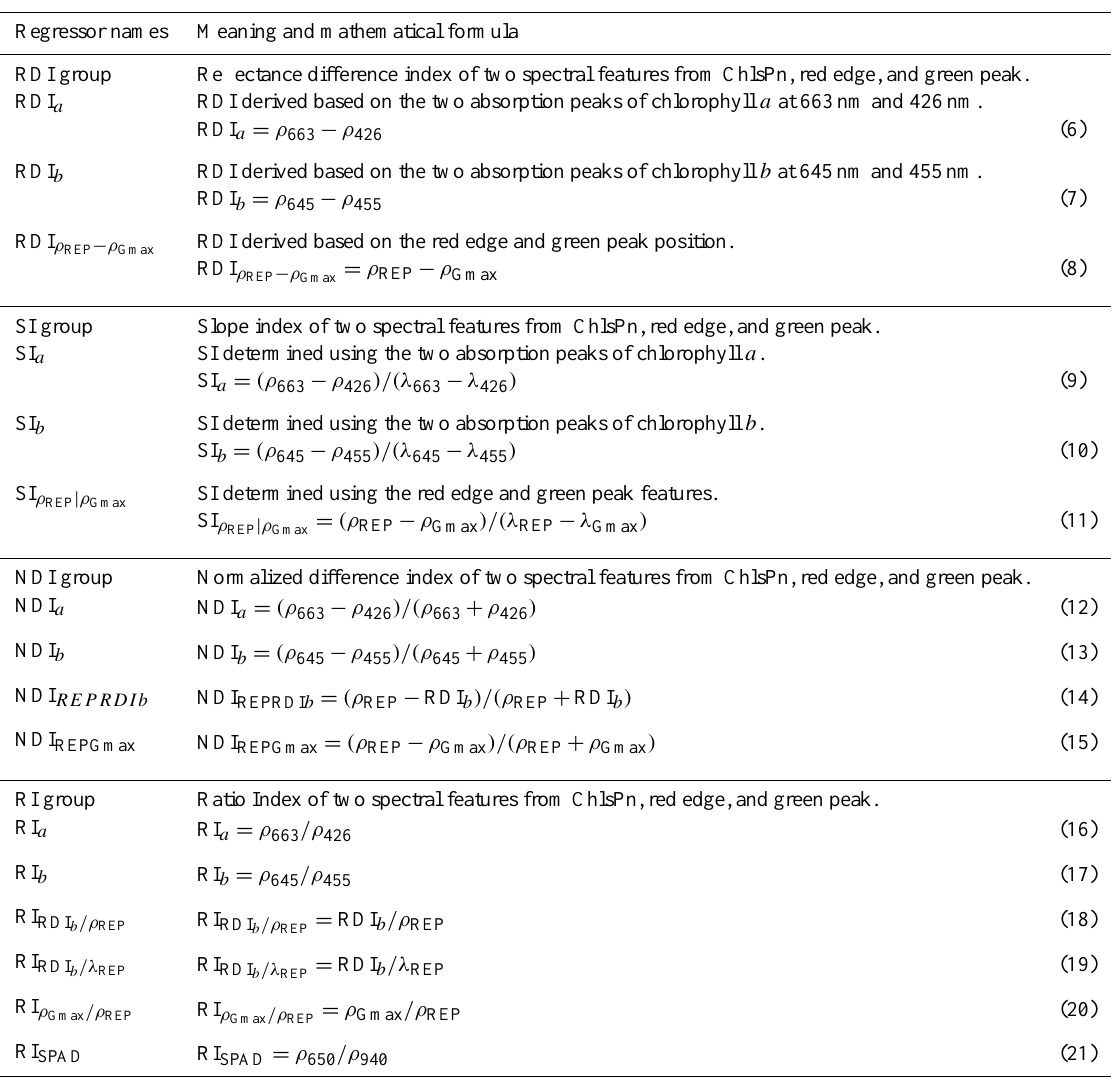
Table 2. The meaning and the formula of some extended spectral indices derived from the ChlsPn variables, red edge, and green peak